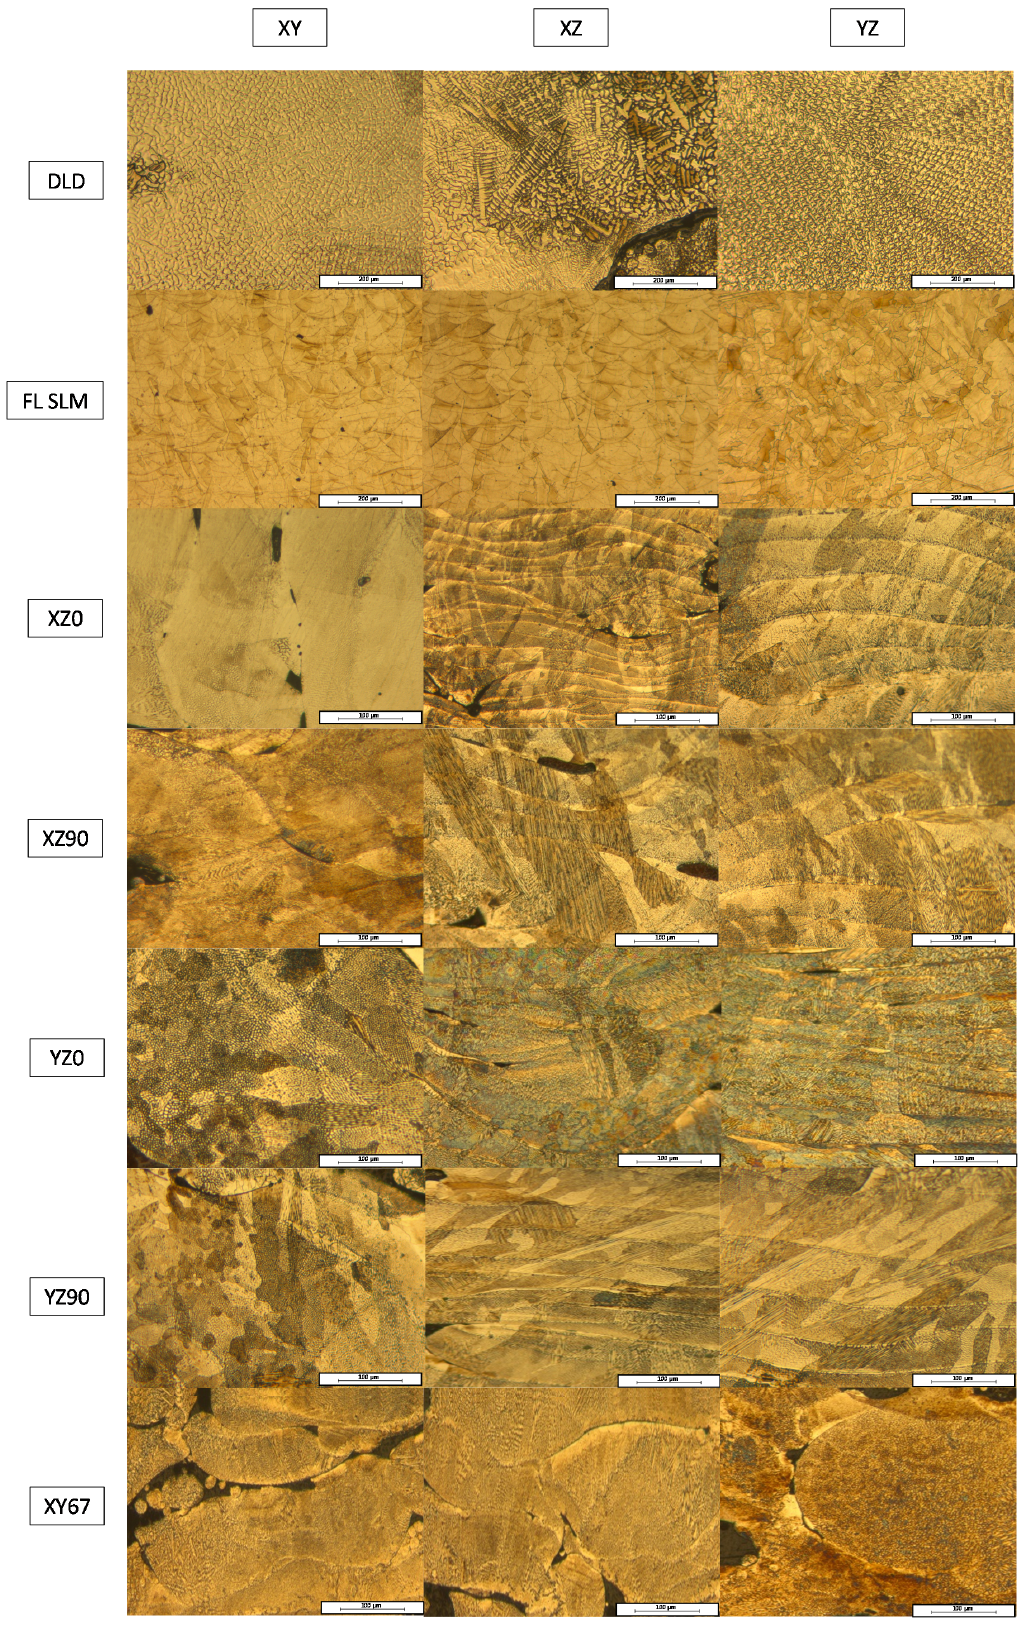
Figure 5. Macrostructure of the manufactured samples. Rows correspond to a manufacturing technique and orientation, and columns show the different cross sections of the